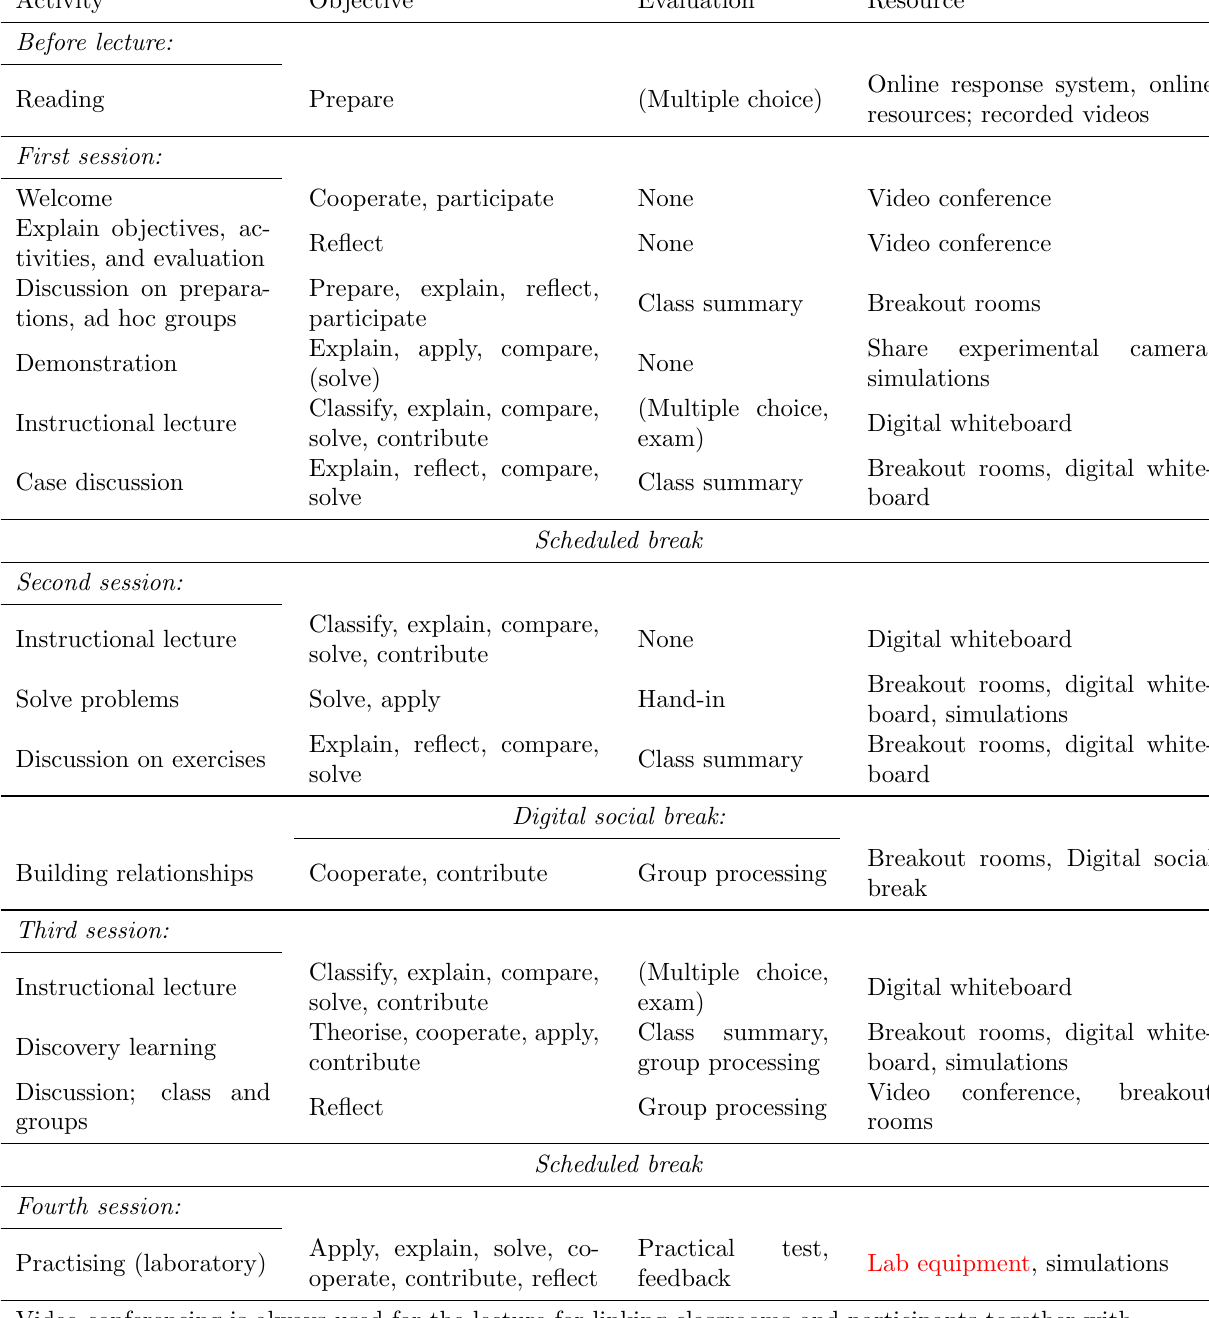
Table 1: Lecture plan for mobile